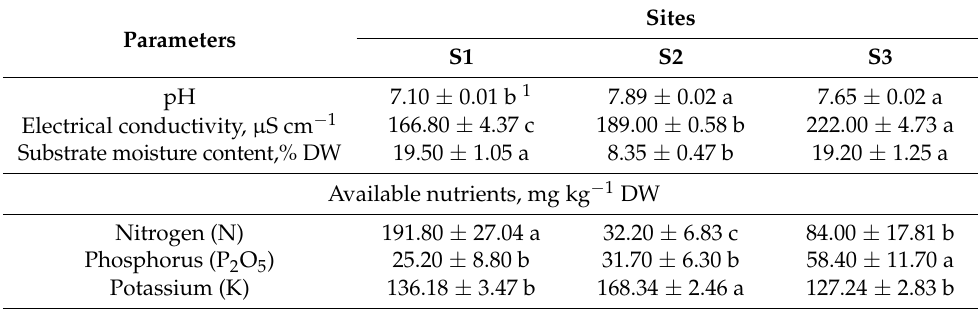
Table 2. The pH values, electrical conductivity and nutrient content in substrates from studied sites.